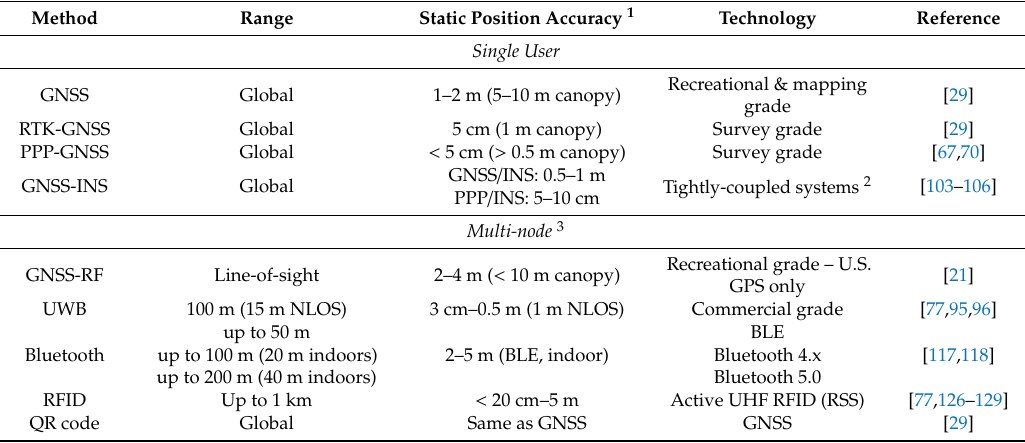
Table 1. PNT technology spatial range and